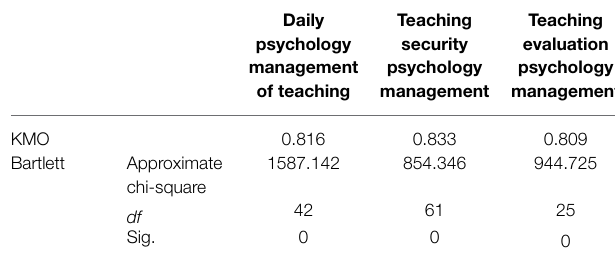
TABLE 3 | KMO and Bartlett’s test